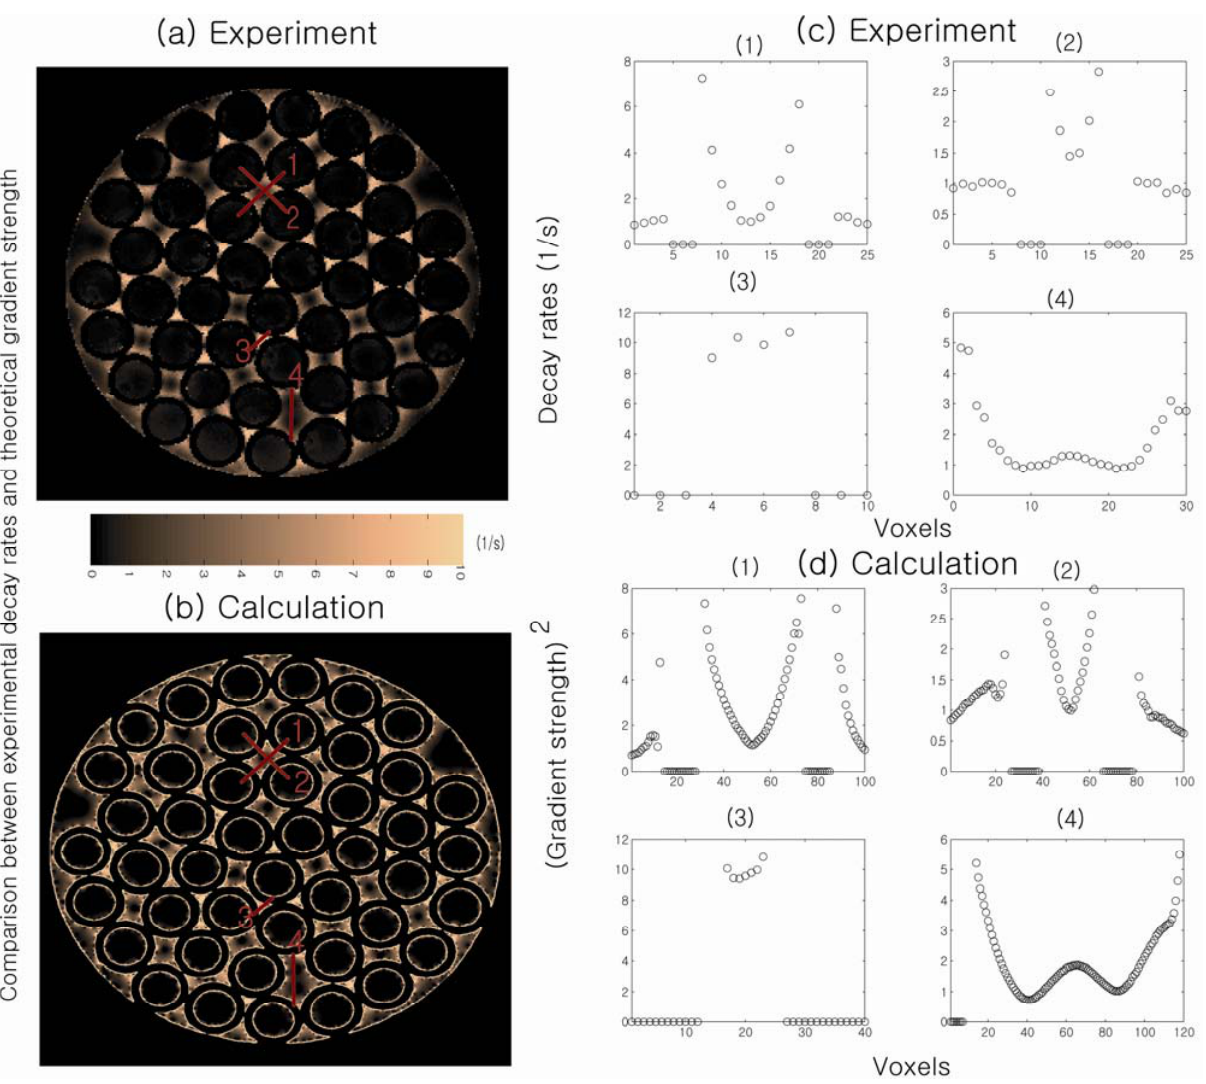
Figure 6. ( a ) Measured DDIF decay rates in packed cylindrical capillary tubes; ( b ) Calculated strength of the internal gradients in the corresponding pore space; ( c ) Experimental measurements of DDIF decay rates along the lines across the pores denoted in (a). ( d ) Theoretical calculation of the squared internal gradient across the lines in the same pore space denoted in (b). Reproduced from Reference [23] with